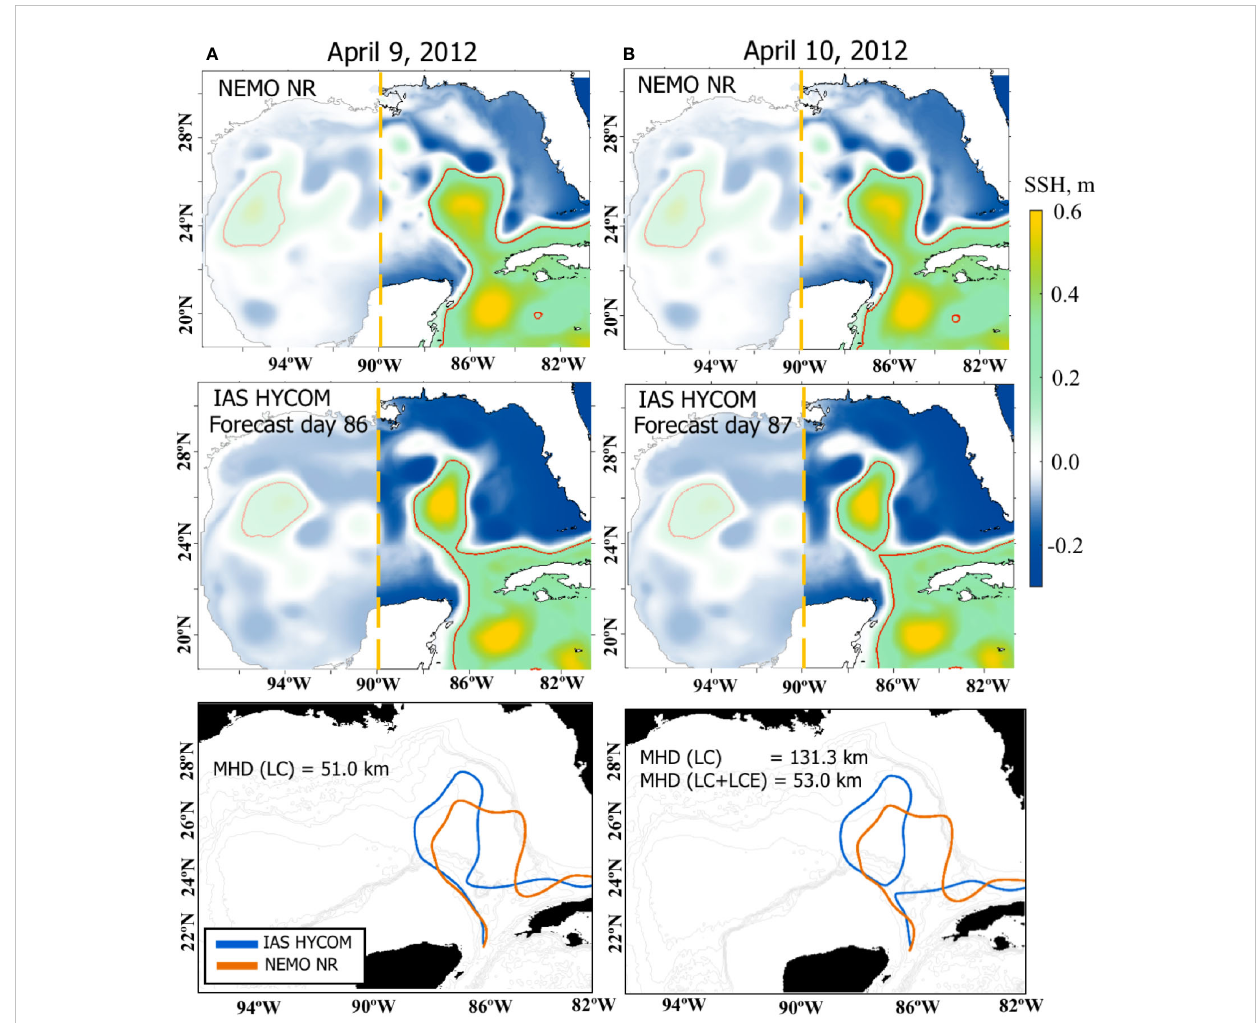
FIGURE 2 The SSH fi elds and the LC/LCE fronts from the NEMO NR (top row) and one of the 1/32.5° IAS HYCOM OSSE forecasts (middle) for April 9, 2012 (left column, A ) and April 10, 2012 (right column, B). The red lines indicate LC/LCE fronts de fi ned as the 17-cm contours of the demeaned SSH. The bottom panels show the LC/LCE fronts used for the MHD calculation with the MHD score listed. For the NR, only LCEs that are in the east of 90°W are considered for the MHD (the eddies that are in the shaded area are ignored). For (B) , the two MHD scores of the forecast (blue) are given: for the LC front only and the LC with the LCE fronts